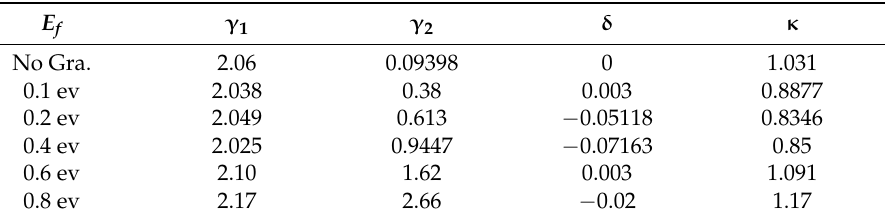
Table 1. The corresponding fitting parameters γ 1, γ 2, δ and κ with different fermi level of the graphene.